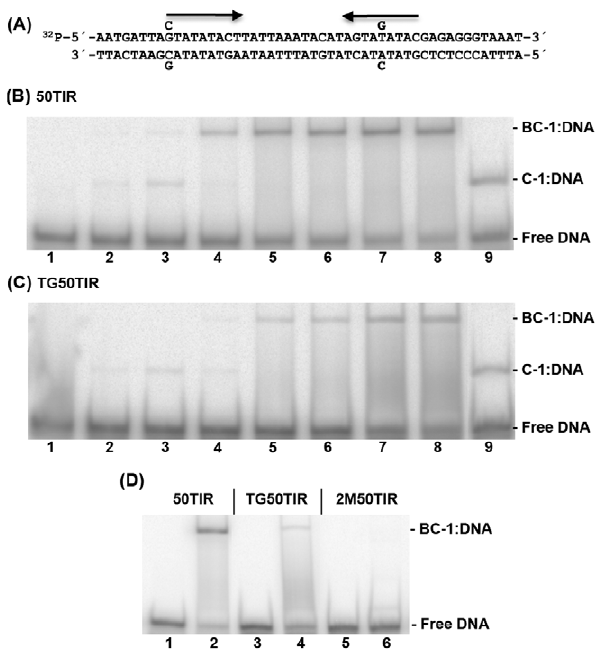
Figure 6. VapBC-1 specifically interacts with the vapB-1 TIR. (A) The sequence of the 50TIR is shown with arrows indicating the inverted repeat regions and bases above and below the sequence indicating the position of the G to C and T to G substitutions in the TG50TIR and 2M50TIR substrates (see Table 3). Gel shift products from a titration of VapBC-1 with (B) 50TIR or (C) TG50TIR are shown. The lanes in panels B and C contain the following samples: DNA only ( lane 1 ), the addition of VapBC-1 at a VapC-1:DNA ratio of 10, 25, 50, 100, 200, 400 or 800 molar ratio with the DNA substrate ( lanes 2–8 ), and VapC-1 only at an 800:1 protein to DNA ratio ( lane 9 ). (D) A comparison of VapBC-1 binding at a 400:1 molar ratio with each DNA substrate ( lanes 2, 4 , and 6 ). Lanes 1, 3 , and 5 contain only DNA. The identity of each band is noted at the right of each gel. Each gel represents one of three independent experiments.